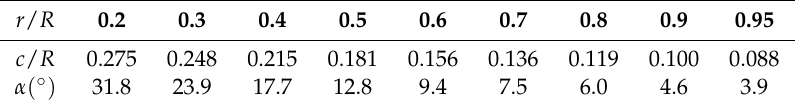
Table 1. Basic geometry of the model wind turbine blades; c denotes the chord length, α represents the angle with respect to the rotor plane, and r and R are the radial distance and rotor radius.